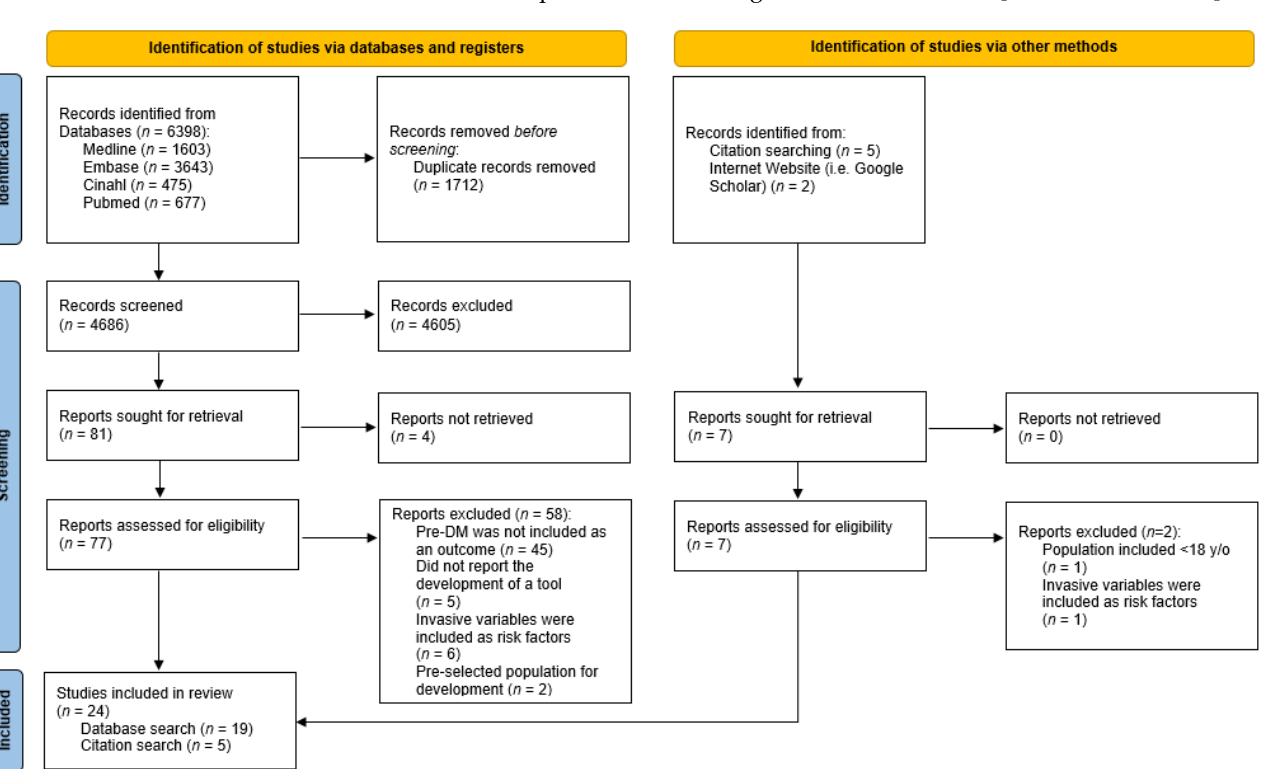
Figure 1. PRISMA flow diagram.